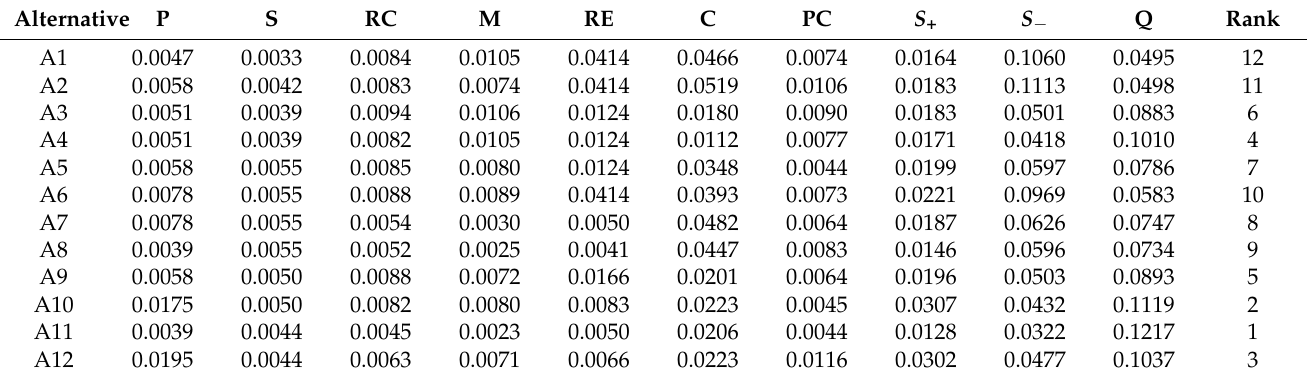
Table 6. Weighted normalized matrix, with performance metrics and rank calculations using